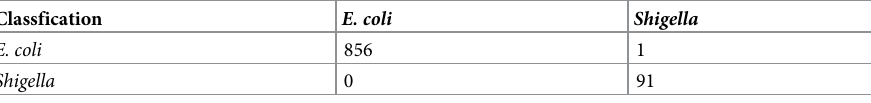
Table 1. Classification of E. coli and Shigella by